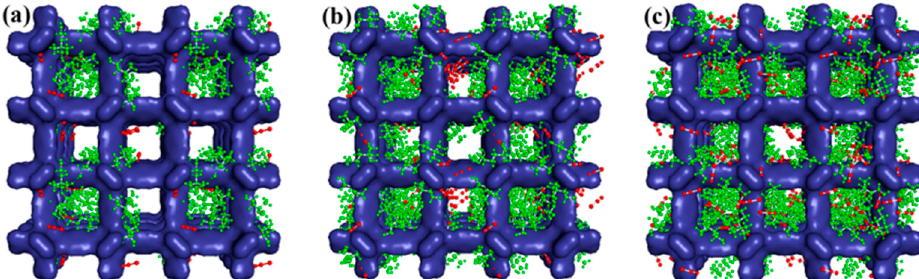
7 of 13 Figure 2. Radial distribution function (RDF) of [Chl]+ and [SCN] − in ( a ) the bulk phase, ( b ) 0.4% w / w , ( c ) 0.8% w / w , and ( d ) 1.2% w / w of IL loading in [Chl][SCN]/IRMOF-1 composites at 298 K and 1 atm. In contrast, both [Chl] + -[Chl] + and [SCN] − -[SCN] − showed unfavourable interaction, since they repelled each other due to their identical charges. It can be seen that the [Chl] + -[SCN] − interaction showed the highest peak intensity at 0.4% w / w loading with the shortest distance of 0.45 nm, but the peak intensity declined at 0.8% w / w and further decreased at 1.2% w / w , as shown in Figure 2b–d, respectively. This observation could be due to the crowding effect of the IL ions. Meanwhile, the interaction of [SCN] − -[SCN] − was higher in both 0.8% w / w and 1.2% w / w with the 0.4 nm distance of interaction. This was because [SCN] − was able to penetrate and move around easily inside the pores of IRMOF-1 due to its small size, making it easier to interact. Furthermore, the bulky size of [Chl] + hindered it to interact with [SCN] − inside the pores. Figure 3 illustrates the snapshot of [Chl][SCN] packed inside the IRMOF-1, which shows the crowding effect by [Chl][SCN] at a high percentage of